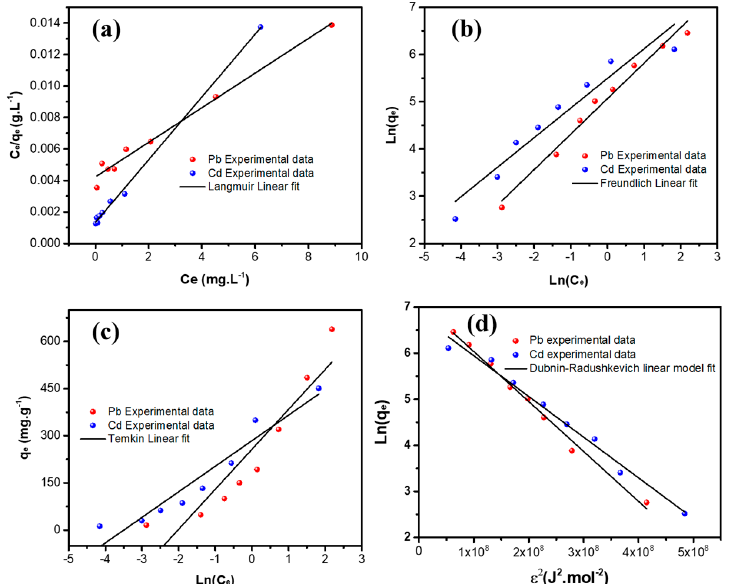
Figure 10. Linear adsorption equilibrium isotherms of Pb ++ /Cd ++ onto MGCN sorbent fitted with the ( a ) Langmuir, ( b ) Freundlich, ( c ) Temkin, and ( d ) Dubinin–Radushkevich models. Table 4. Isotherm parameters for the adsorption of Pb ++ /Cd ++ ions onto MGCN sorbent.